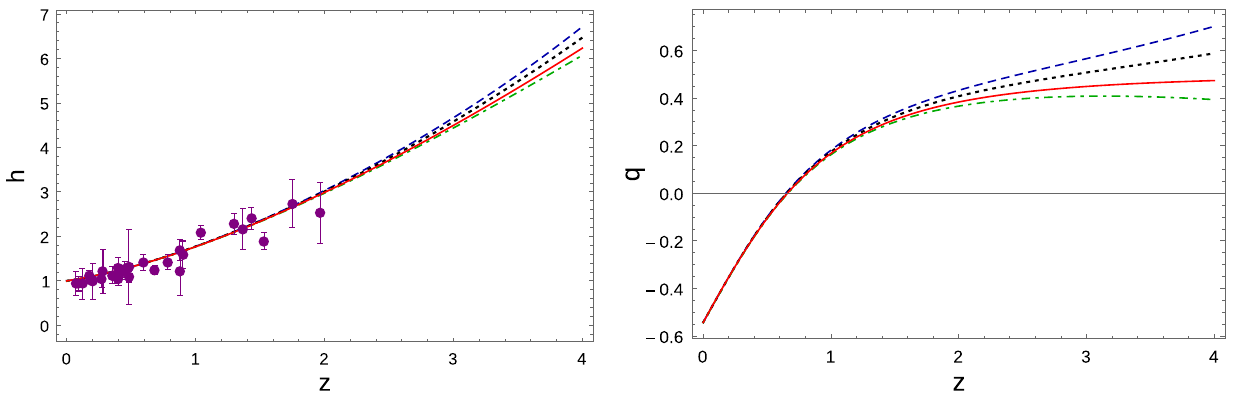
curve) and ¯ α = 0 . 0007 (dot-dashed curve). For the Hubble parameter, we have also plotted the observational data together with their errors [168–176]. The (cid:7) CDM curve is depicted as a red solid